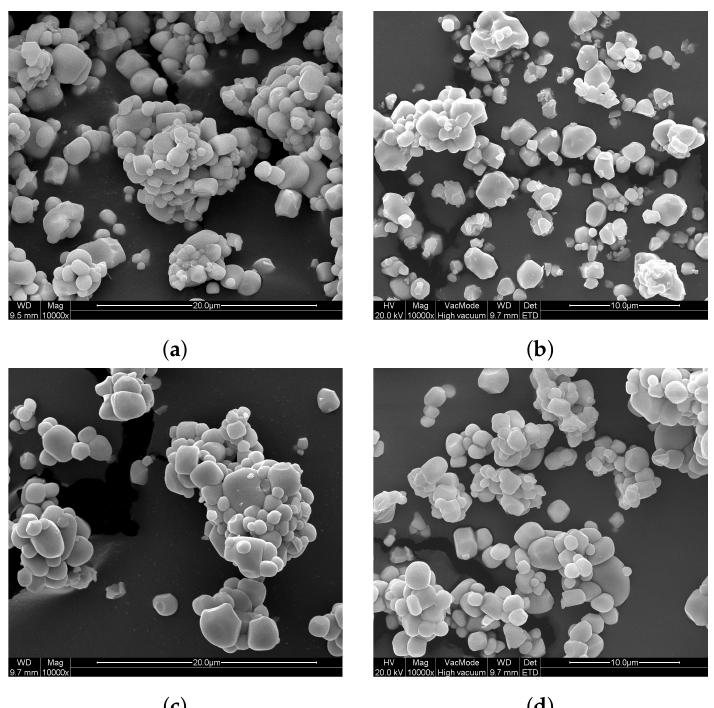
Figure 3. SEM images: ( a ) GA1000 sample, ( b ) GA1000_W sample, ( c ) GV1000 sample, and ( d ) GV1000_W sample. All scales are